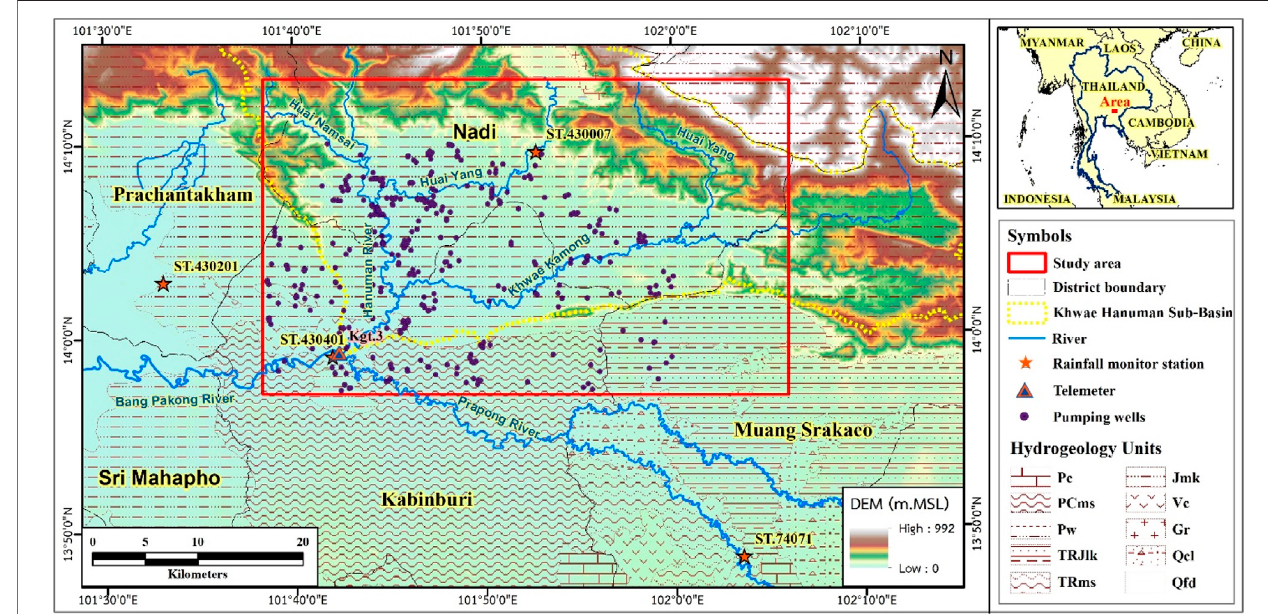
FIGURE 1 | Location of the study area in the LKH sub-basin, Prachin Buri Province, Thailand.